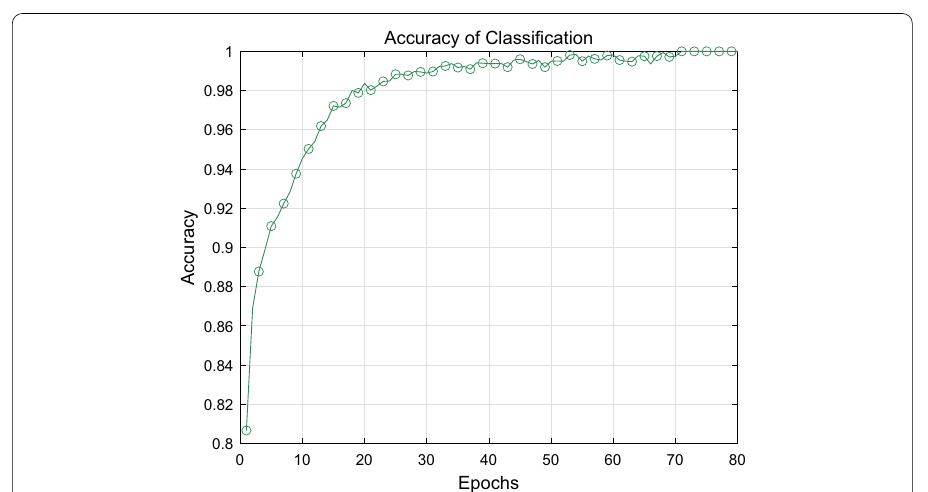
Fig. 15 Acc curve of classification results by the proposed framework with respect to